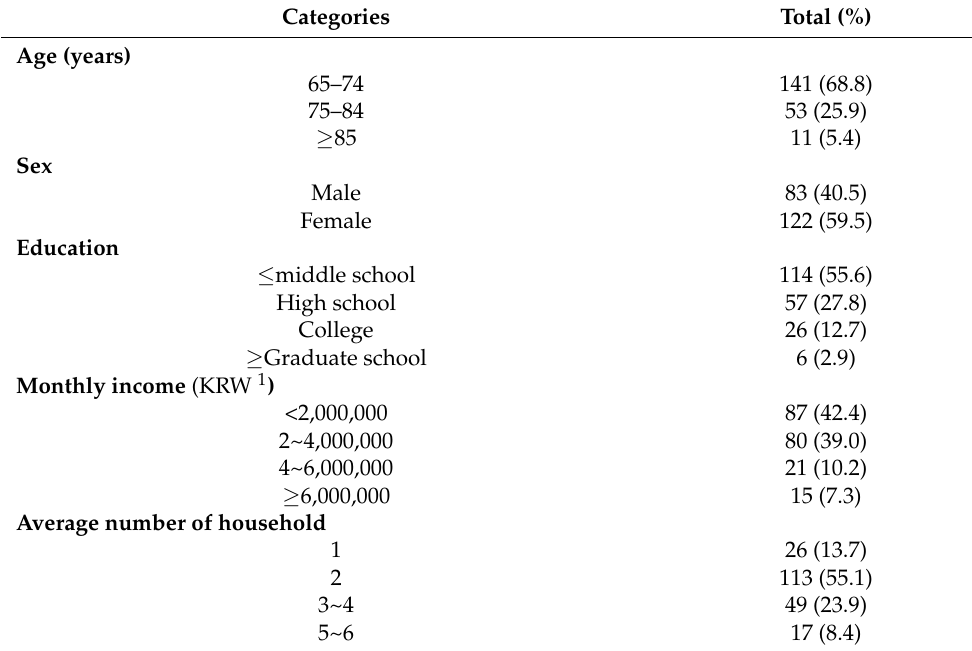
Table 2. General characteristics of the participants ( n = 205).